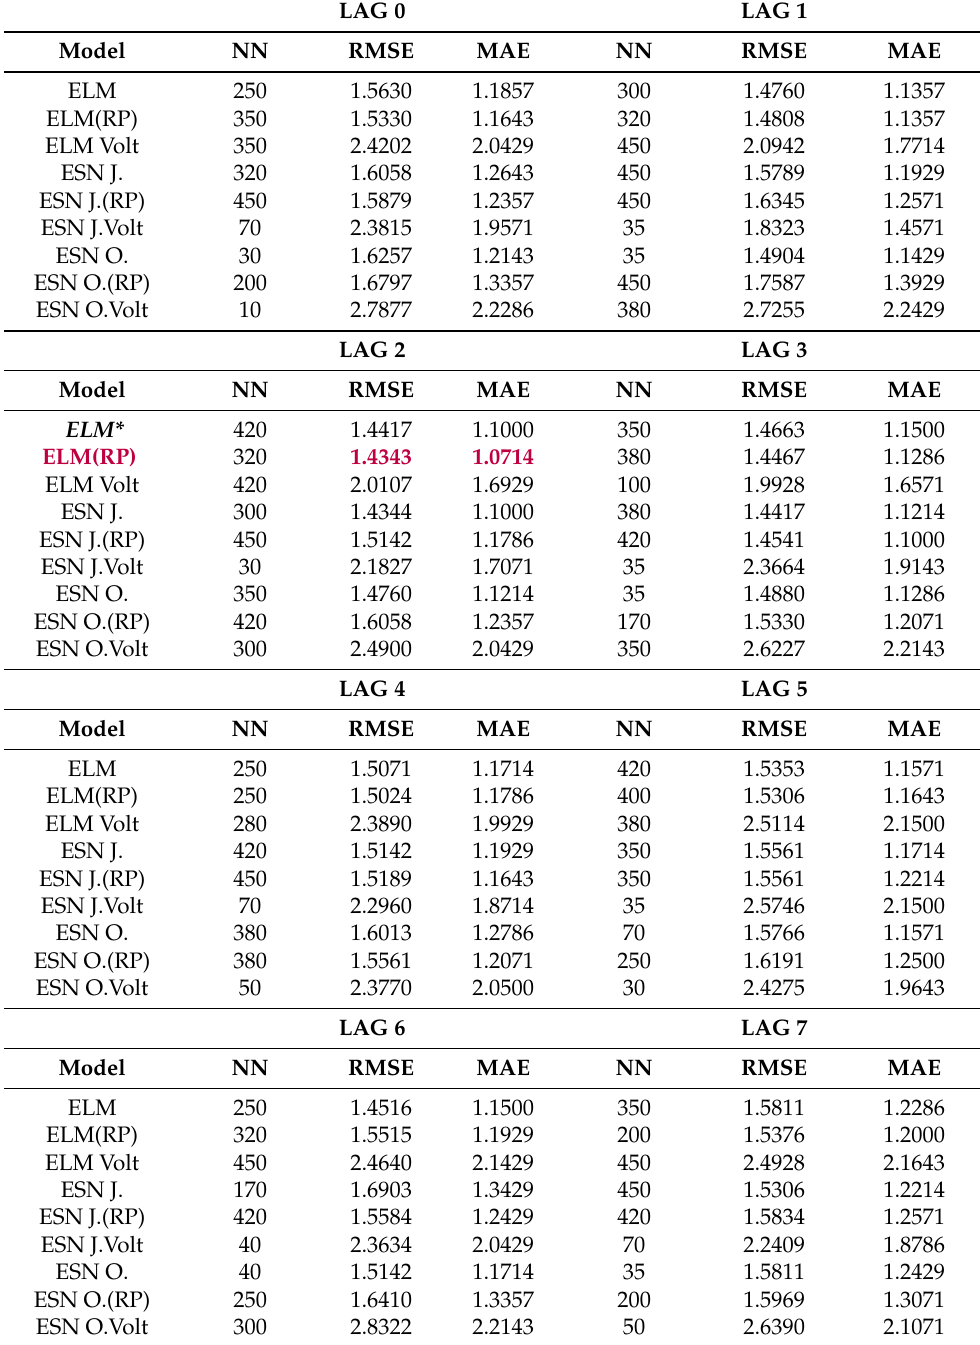
Table 3. Results for Cubatão (Number of neurons-NN, RMSE and MAE for each model and